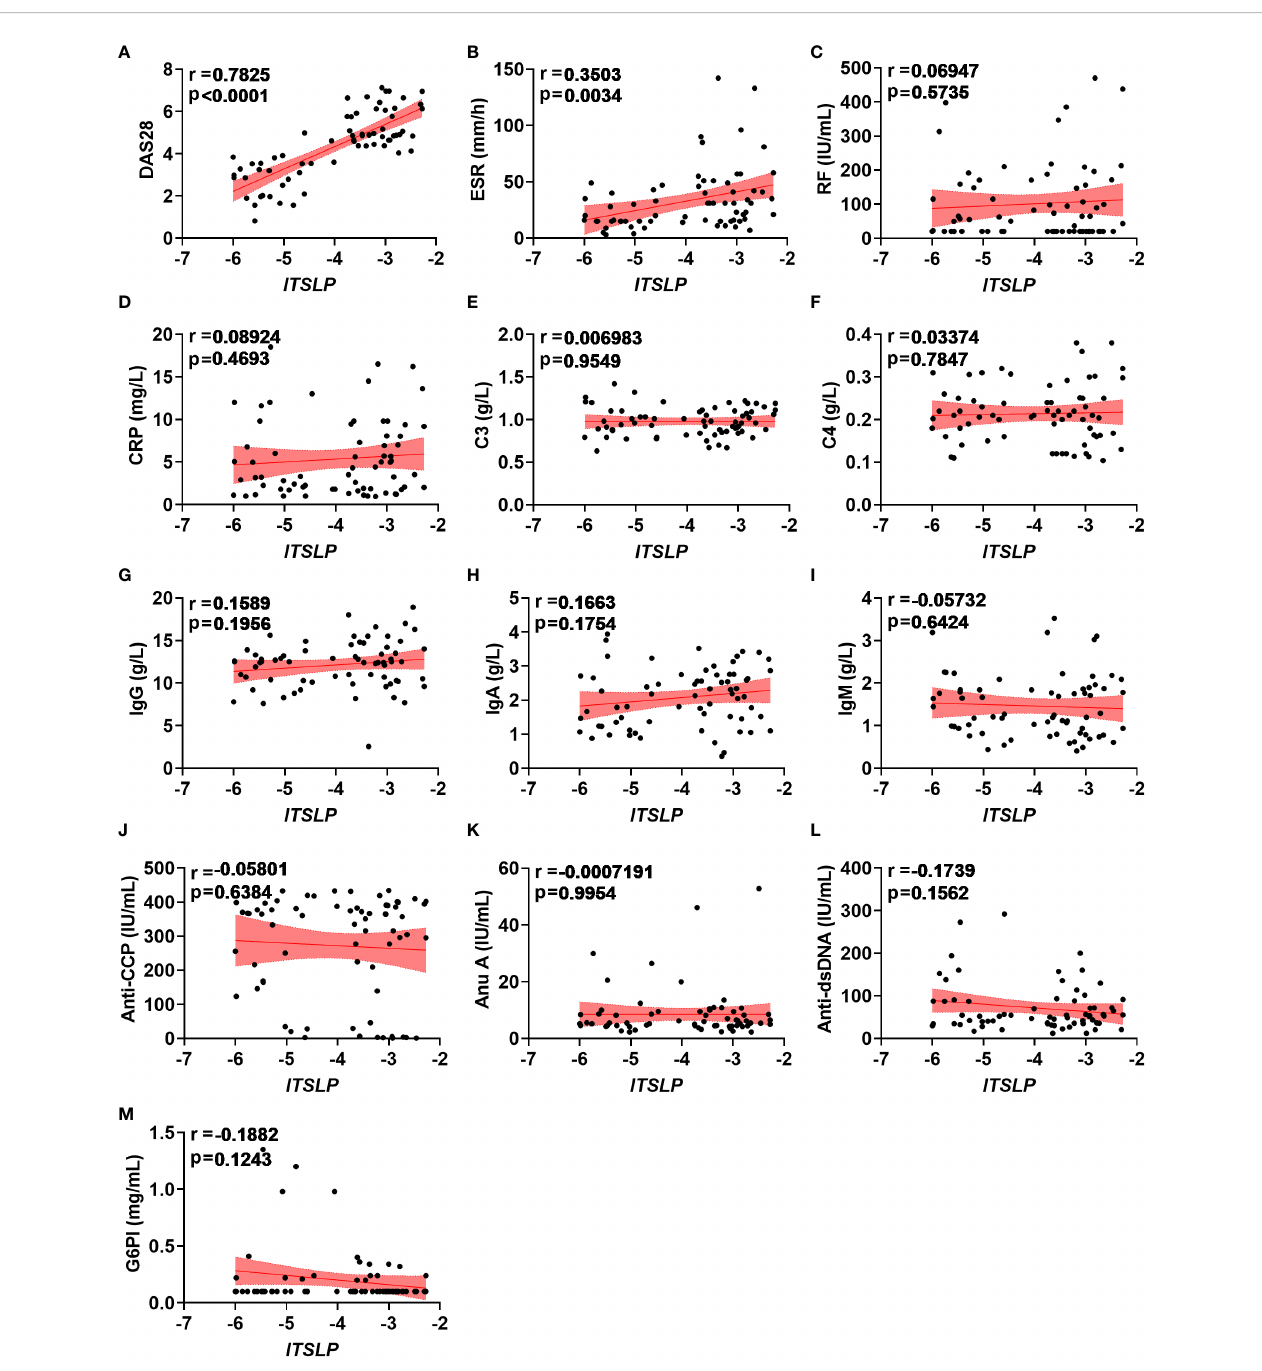
FIGURE 2 Correlations between lTSLP expression and RA clinical values. (A-M) The relationship analysis of lTSLP mRNA expression with laboratory values, including DAS28 (A) , ESR (B) , RF (C) , CRP (D) , C3 (E) , C4 (F) , IgG (G) , IgA (H) , IgM (I) , Anti-CCP (J) , Anu A (K) , Anti-dsDNA (L) , and G6PI (M) . The correlation was determined using Spearman ’ s non-parametric test. Each symbol represents an individual RA